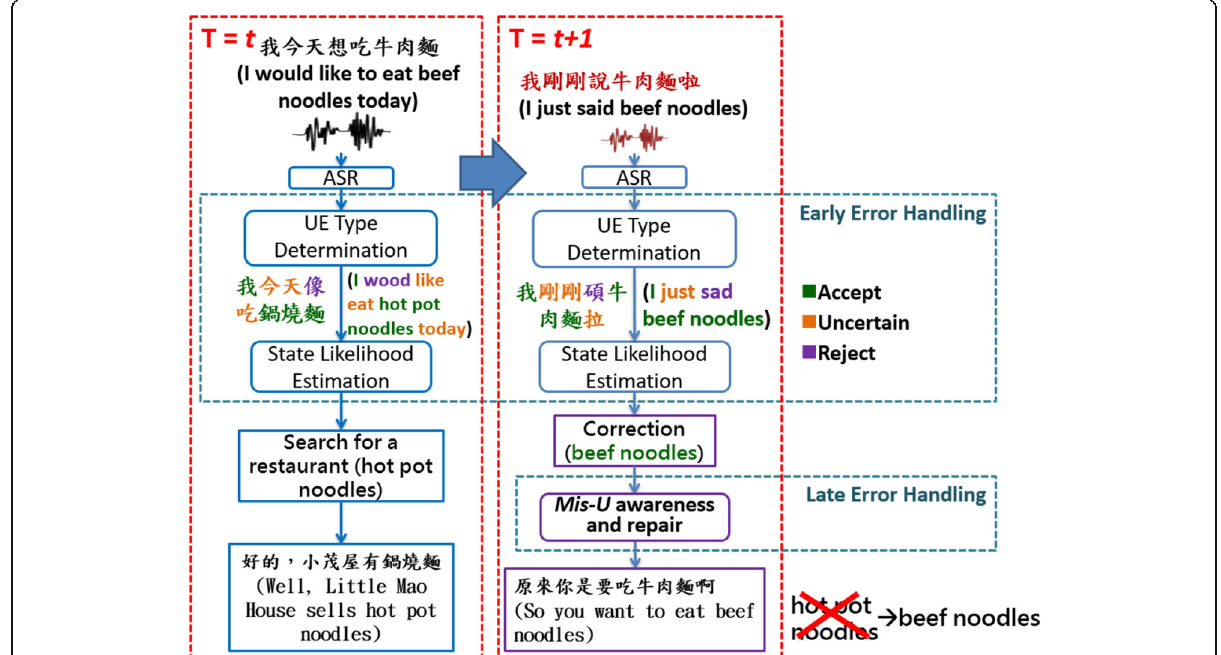
Fig. 1 An example for the occurrence of a Mis - U and the correction made by the user in the next dialog